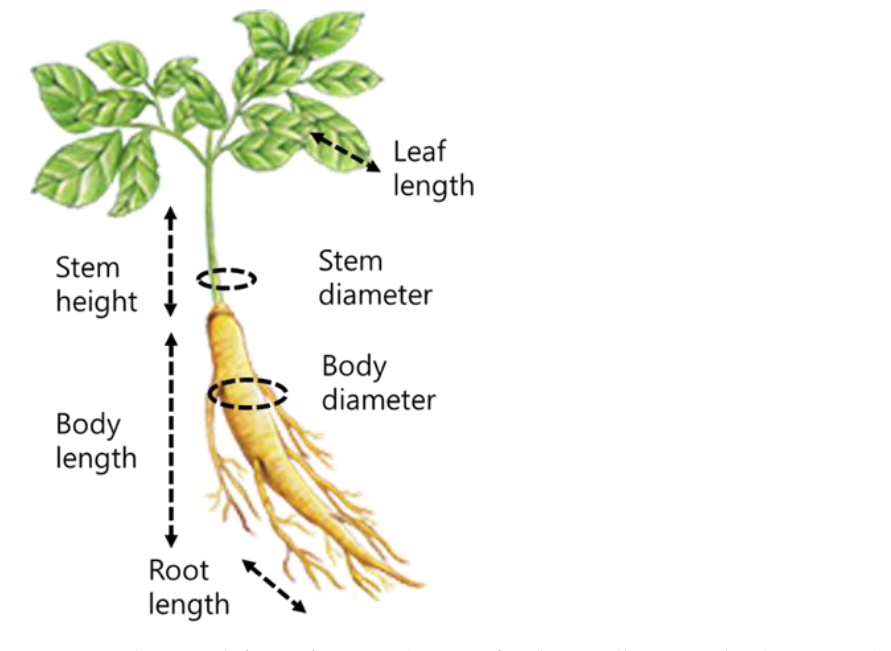
Figure 2. The growth form of ginseng (names of each part, illustration by the National Agricultural Cooperative Federation